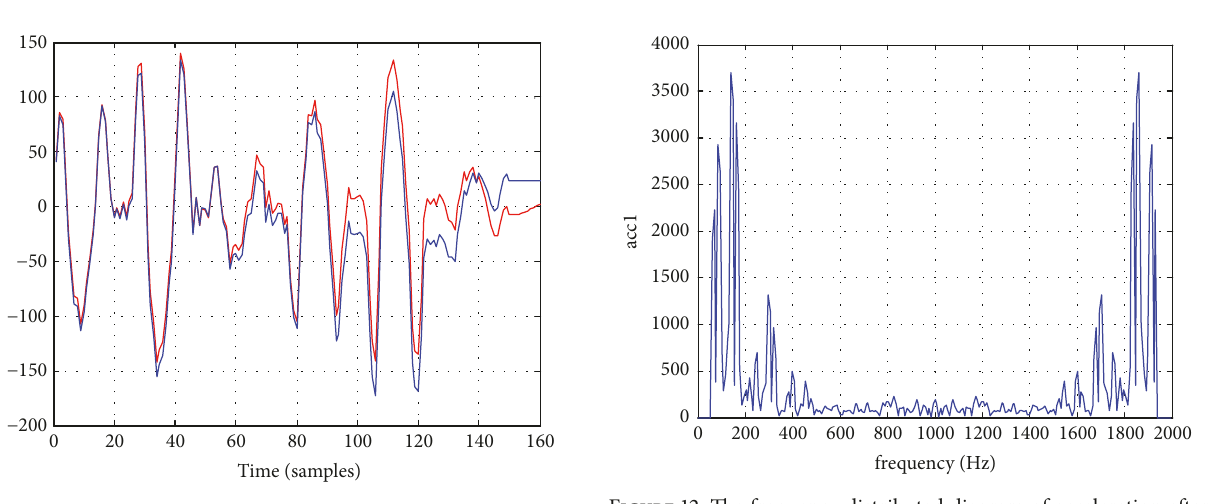
Figure 12: The frequency distributed diagram of acceleration after